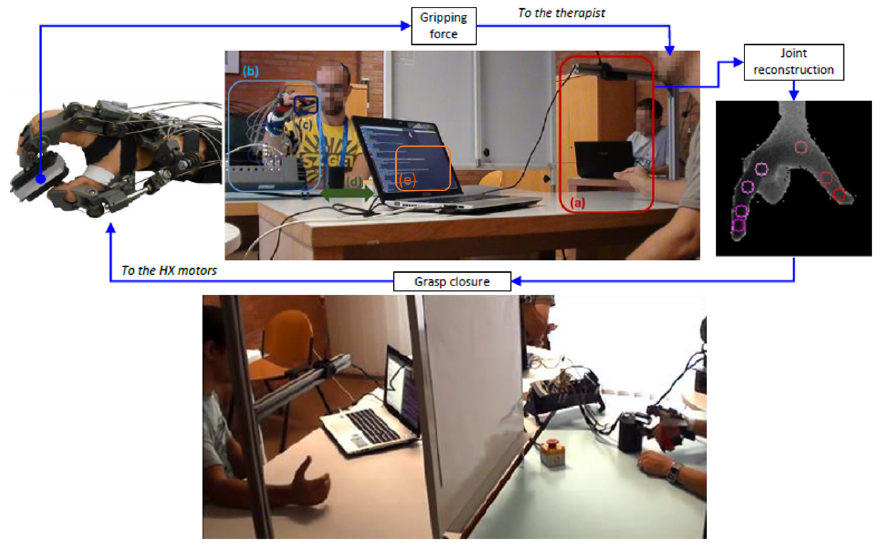
Figure 6. Experimental setup pipeline. ( a ) master unit: the VPE camera computes the joints positions of the operator’s hand; ( b ) slave unit: the subject wears the HX exoskeleton, which drives his/her fingers towards closure; the subject can freely move the arm; ( c ) squeezable grip sensor; ( d ) bi-directional link is realized through a UDP/IP communication between the VPE acquiring PC and the real-time control board driving the HX; ( e ) in the same PC, the operator visualizes in RT gripping force feedback from the slave unit. Down: same setup, addressing a lateral grasp. The white panel prevents the subject from having a visual clue of the operator’s